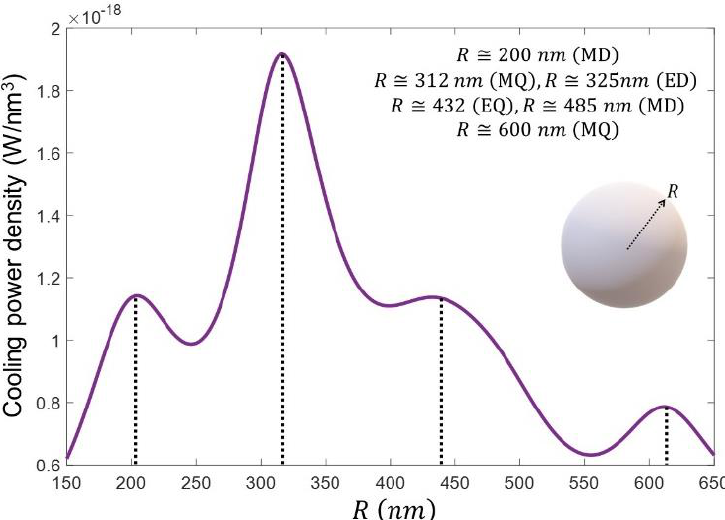
Figure 3. System under investigation. Here, λ P and λ F are the pump and mean fluorescence wavelengths, respectively [29].